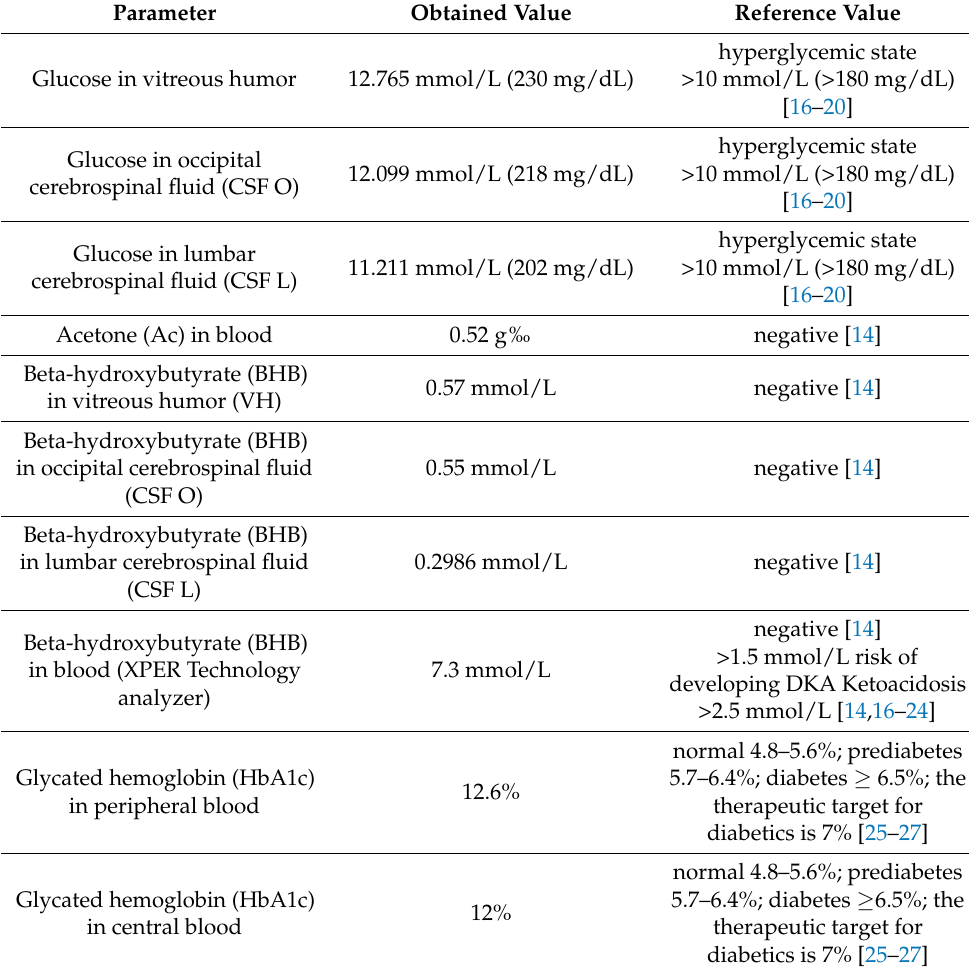
Table 1. Results for the biochemical parameters